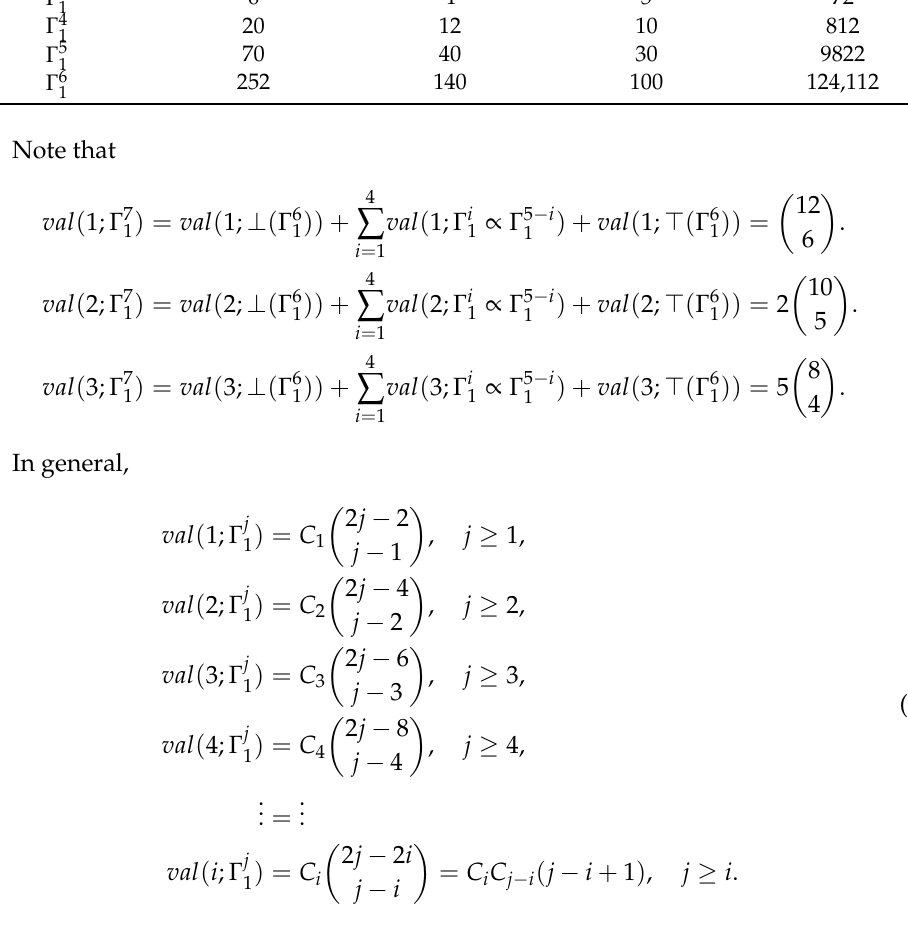
) of vertices i = 1,2, and 3 in Γ j 1